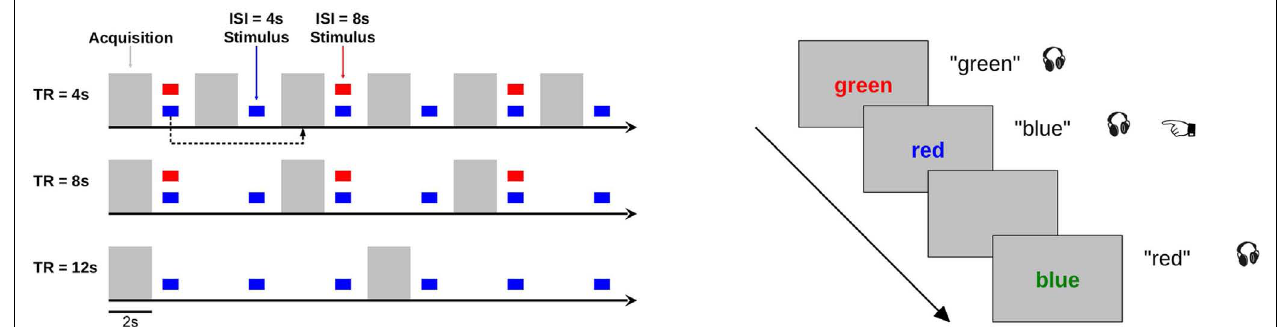
was theTA immediately following the event; forTR = 4s acquisition, this was the subsequentTA (as indicated by the black dashed arrow).The task design is illustrated at right. In a modified Stroop task, a color word was displayed in a colored font. Concurrently, participants heard the name of a color spoken over the headphones. Participants pressed a button (illustrated by the pointing finger) whenever the spoken color word matched the text